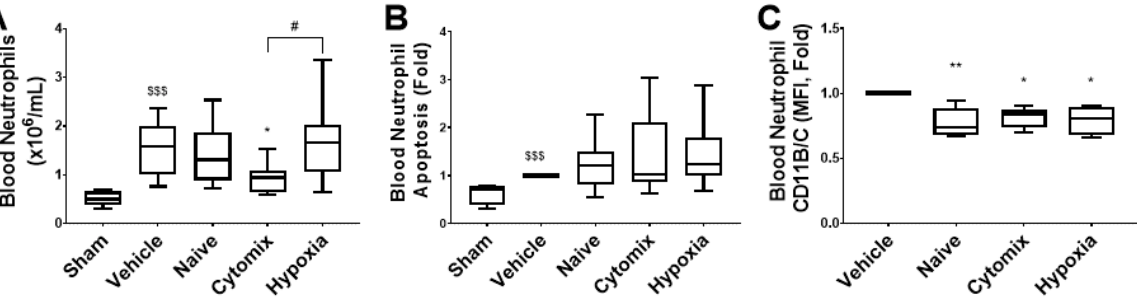
Figure 9. Flow cytometry analysis revealed that the population of circulating neutrophils increased in response to K. pneumoniae infection, and this was significantly attenuated by the administration of cytomix MSCs ( A ). The percentage-fold change in neutrophil apoptosis appeared to be increased ( B ), and the activation was significantly decreased by all MSC-treated groups ( C ). MFI = median fluorescence intensity; IL = interleukin; TNF- α = tumor necrosis factor alpha. Box plots and whiskers represent the minimum, first quartile, median, third quartile, and maximum. Columns represent means, and error bars represent SDs. *, ** = p ≤ 0.05, 0.01 with respect to the vehicle control. $$$ = p ≤ 0.001 with respect to the sham group. # = p ≤ 0.05 with respect to other treatment. N =